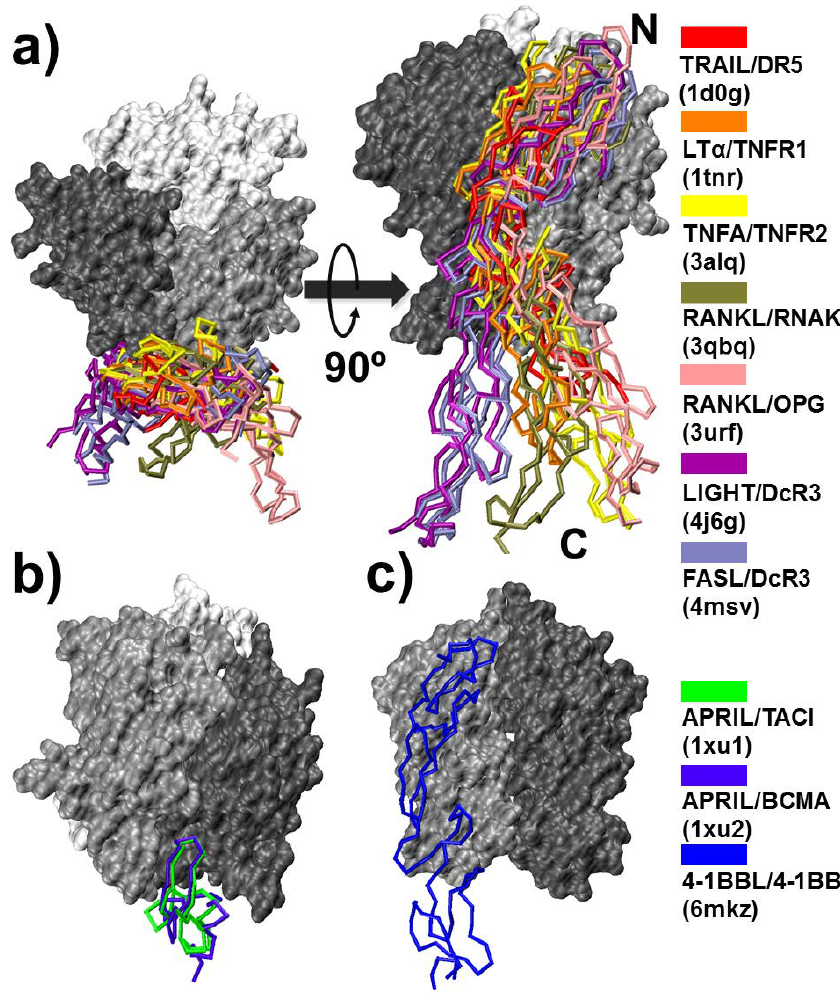
Figure 2. We compared the structure of the interactions between ligands and receptors of the 10 TNF / TNFR complexes in the dataset. The color index of these complexes is listed on the right side. Specficially, binding between ligands and receptors can be divided into three groups. Firstly, 7 out of 10 receptors in the dataset could be closely aligned with each other, as shown in ( a ). The second group, as shown in ( b ), is the structural comparison of a pair of functionally related receptors, B cell maturation antigen (BCMA; violet) and short form of transmembrane activator and CAML-interactor (TACI; green). Finally, the binding between receptor 4-1BB and its ligand 4-1BBL, as shown in ( c ), is highly di ff erent from the first two.